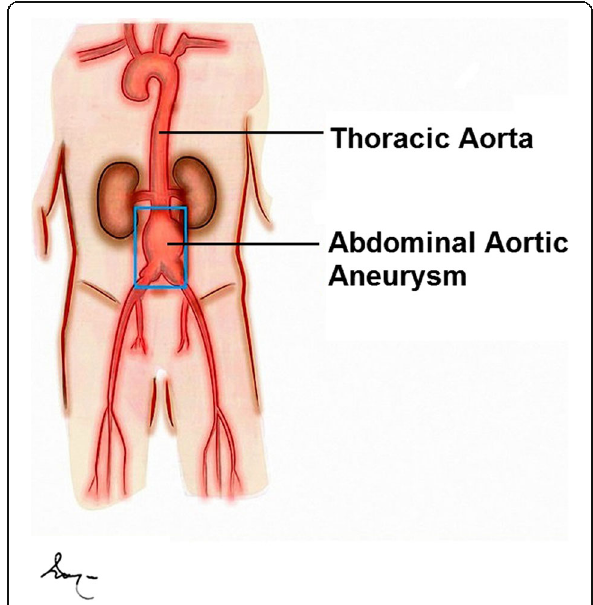
Fig. 1 Schematic drawing of the human aorta and the location in the infrarenal portion of an Abdominal Aortic Aneurysm